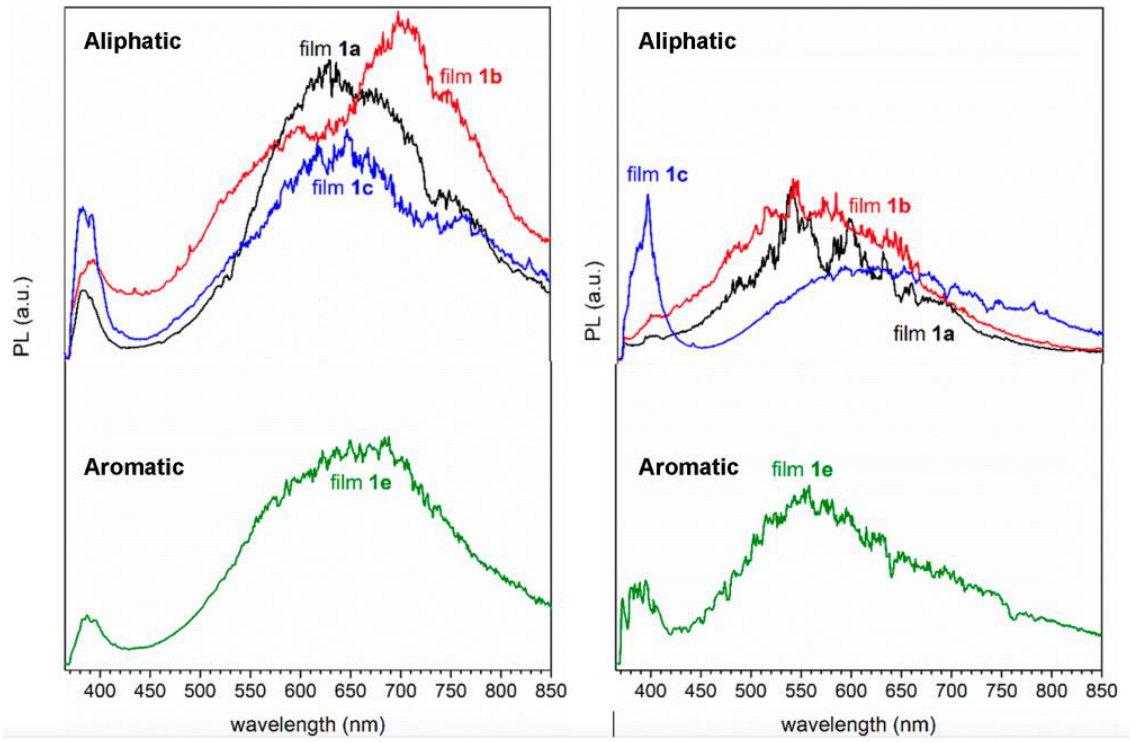
Figure 9. Photoluminescence spectra of the films annealed at 600 °C ( left ) and at 300 °C ( right ), recorded at room temperature.